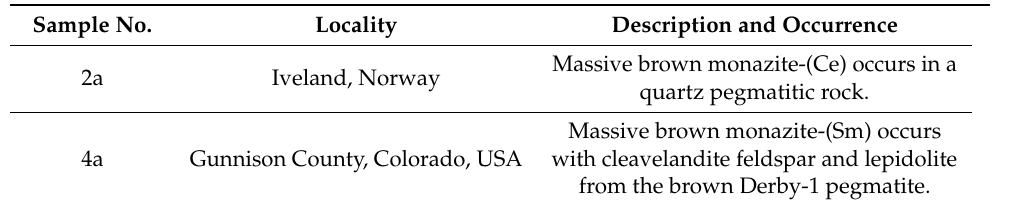
Table 1. Monazite sample